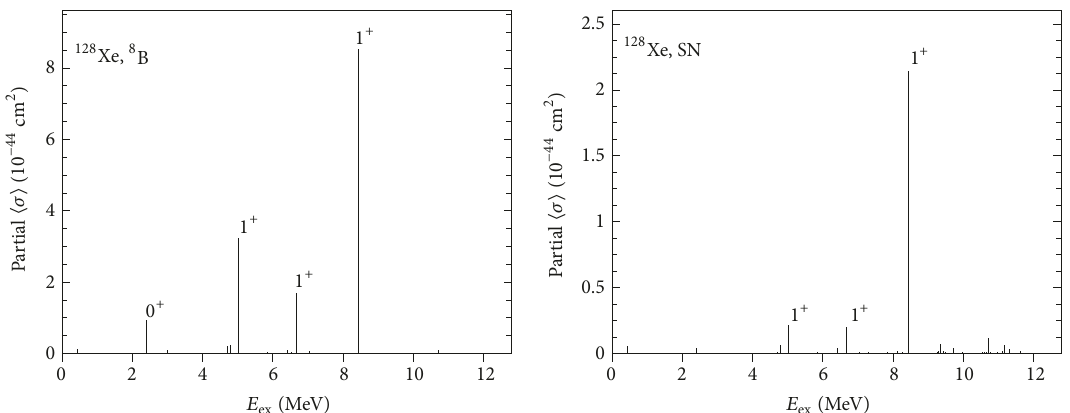
Figure 6: Contributions to the inelastic scattering averaged cross section arising from various final states of 128 Xe at energies 𝐸 shown for 8 B solar neutrinos (left panel) and supernova electron neutrinos (right panel). Cross sections are given in units of 10 −44 cm 2 for solar neutrinos and 10 −42 cm 2 for supernova neutrinos.